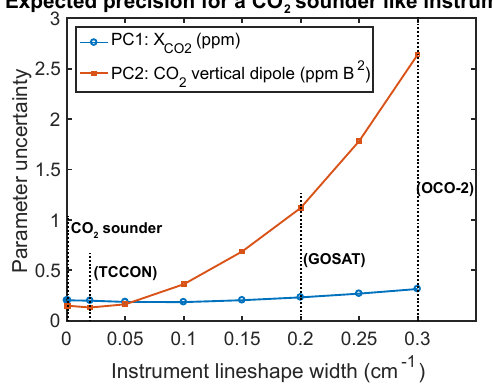
Figure 4. Retrieval uncertainty versus instrument spectral linewidth for the first two CO 2 principal components (PCs): while the column X CO is largely unaffected by the spectral resolution, the precision 2 of the CO 2 vertical dipole moment degrades strongly with poorer resolution. We assume a CO 2 instrument model, but with some in- strument line broadening. The x axis denotes the full width at half maximum of the triangular instrument lineshape used to broaden the CO 2 absorption. We assume photon shot noise with an SNR of 1000 for points with no CO 2 absorption. The spectral resolutions of TCCON (Wunch et al., 2011), satellite GHG-sensing spectrometers (Kuze et al., 2009; Connor et al., 2008) and the CO 2 Sounder instru- ment are indicated, though the calculations done in this work apply only to the CO 2 Sounder instrument. Typical actual precisions for X CO are 0.15ppm for TCCON (Wunch et al., 2011), 0.6ppm (land 2 only) for ACOS GOSAT (O’Dell et al., 2012), and 0.55ppm (land only) for OCO-2 (Connor et al., 2016a).